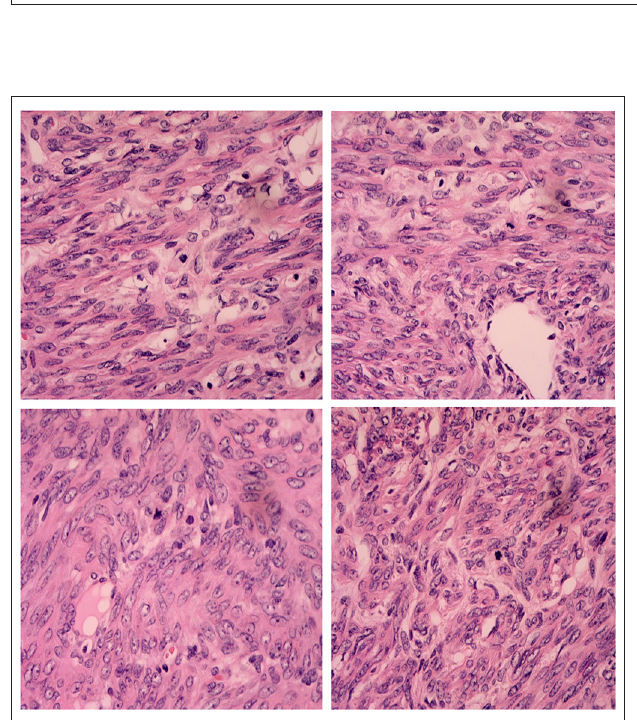
FIGURE 2 | The gross characteristics of ovarian leiomyoma obtained for case 8. (A) Two solid, irregular, vascular-appearing mass was shown; the left growing from the uterine, while the other from the right ovary; the uterus was normal. (B) The thickened ovarian inherent ligament and enlarged right ovary with a sharply demarcated border, no adhesion, and no infiltration of the surrounding structures.